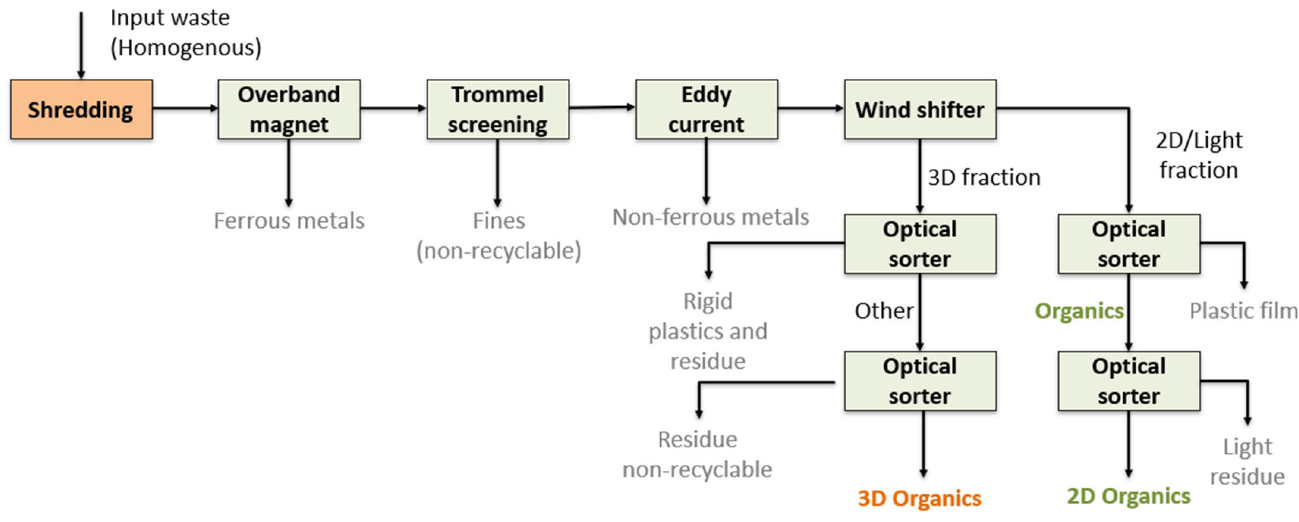
Figure 1. Schematic overview of the separation of paper and cardboard from waste .